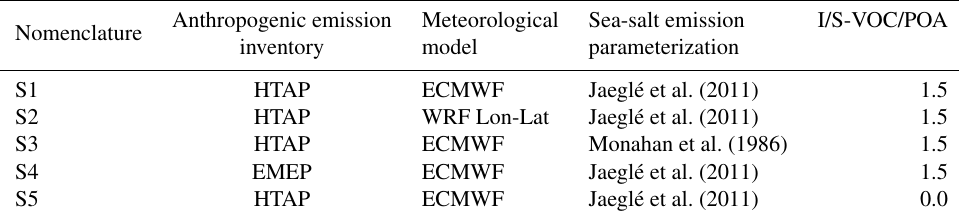
Table 1. Summary of the different simulations and their input data. S1, S2, S3, S4 and S5 represent the simulation